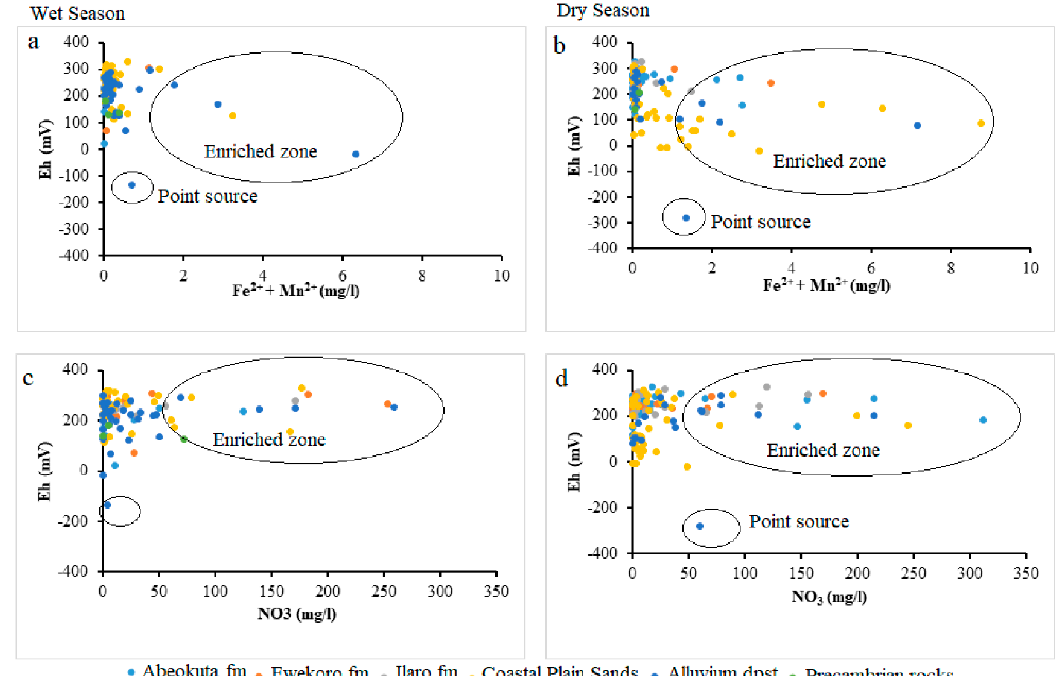
Figure 10. Scatter plots (Fe 2 + + Mg 2 + ) against Eh ( a ) wet season ( b ) dry season and NO 3 against Eh ( c ) wet season ( d ) dry season.